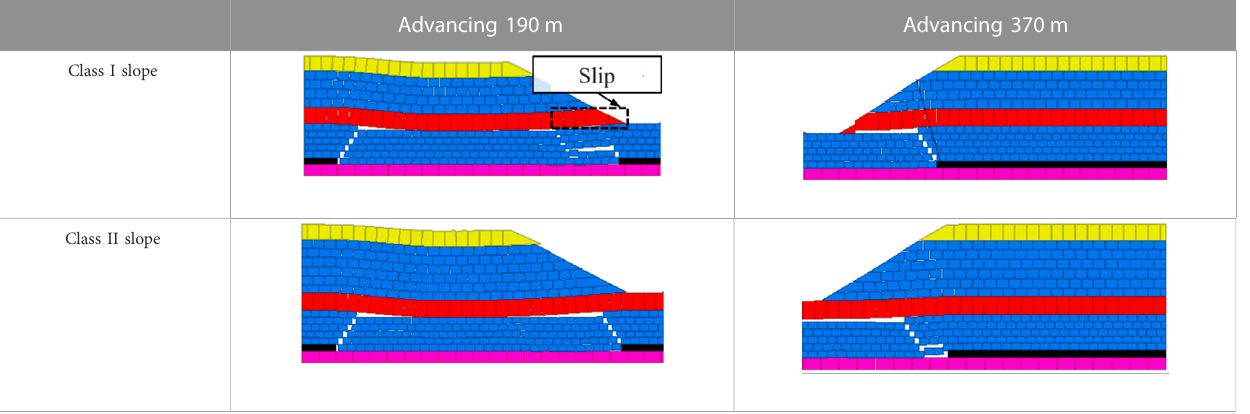
TABLE 5 Characteristics of overburden movement and failure in the basic